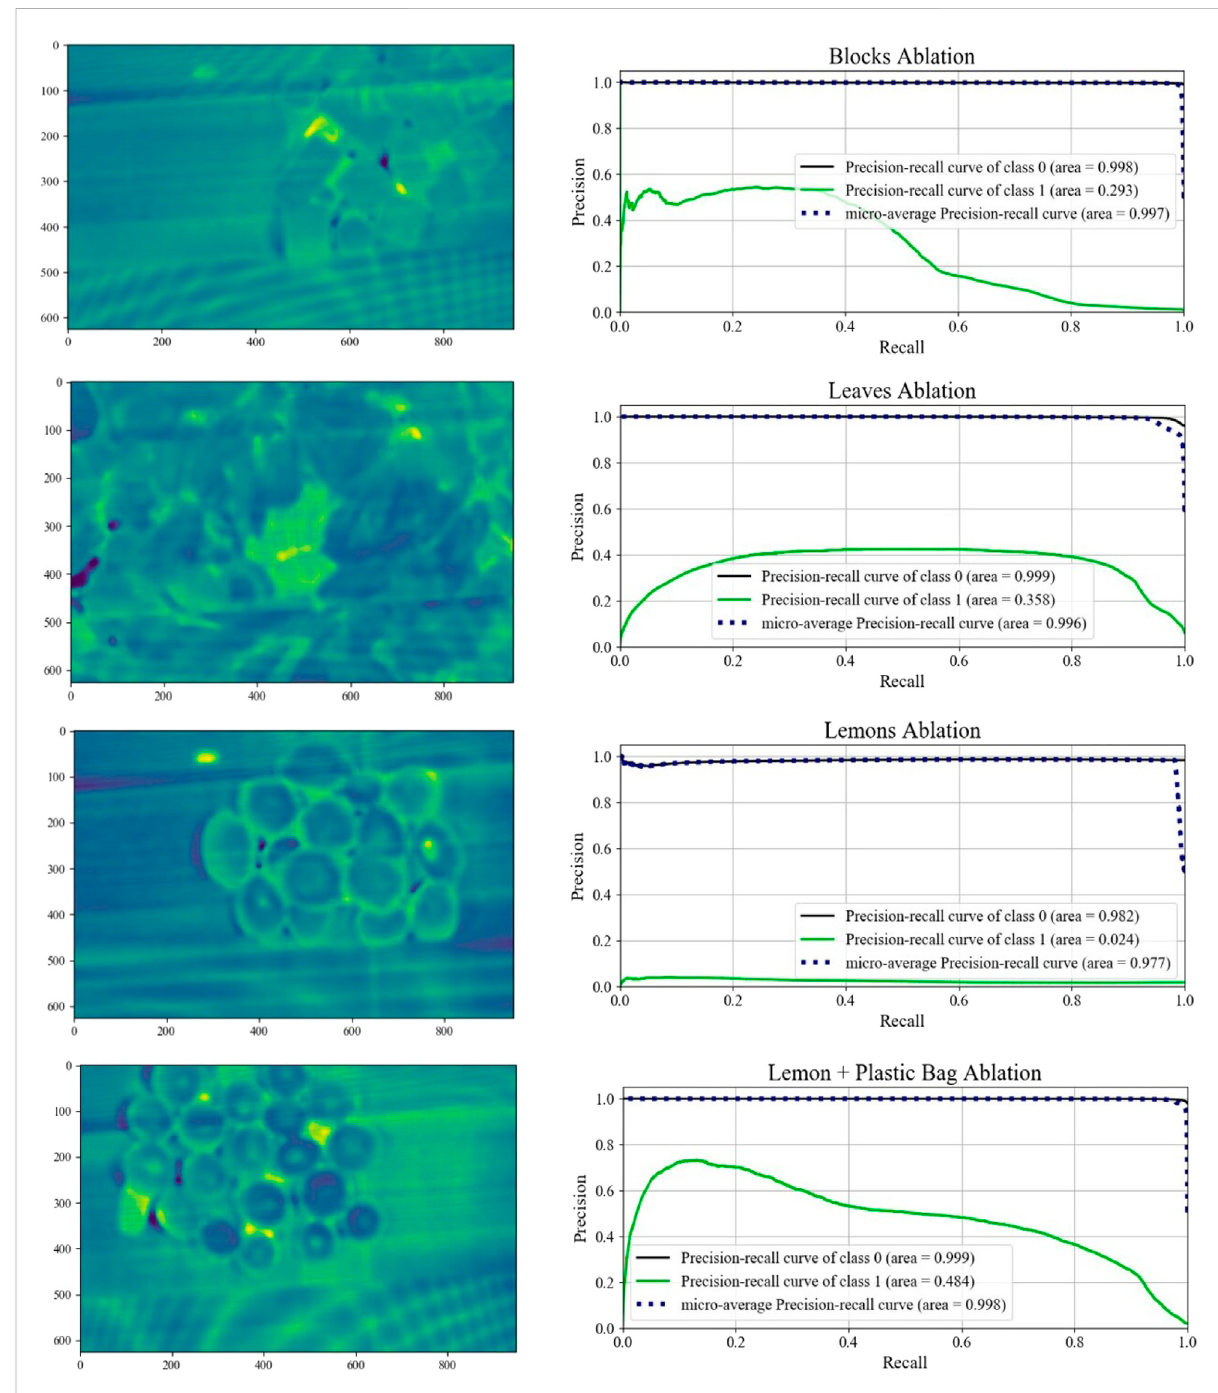
FIGURE 13 Mean absolute reconstruction error for each of the four environments and their associated precision recall curves conducted for the ablation